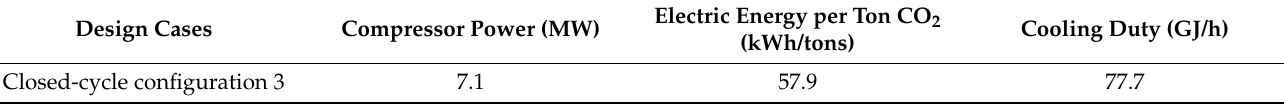
Figure 16. Heat curve of configuration 3.